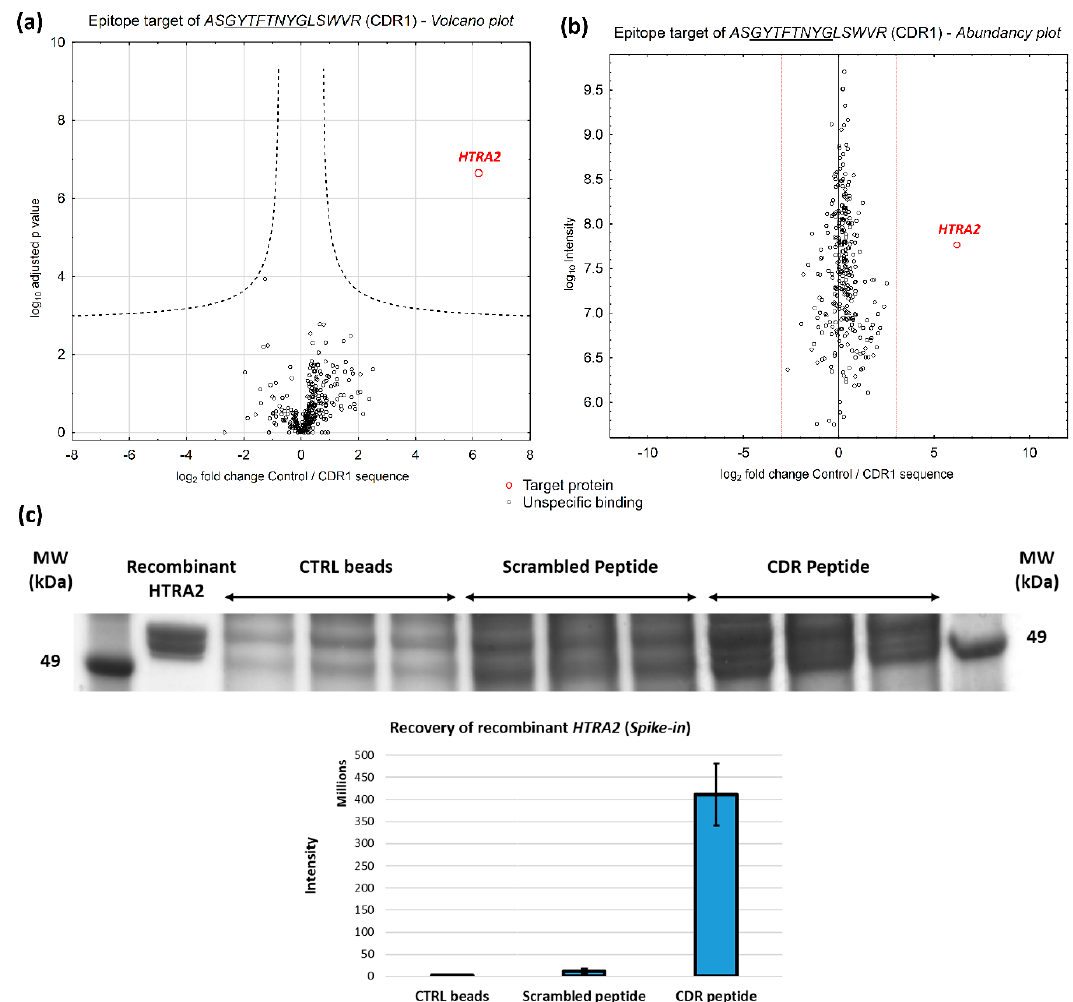
Figure 2. Identification of potential epitope targets of the CDR peptides by affinity-based proteomic strategy with 5 mg homogenized pig retina. ( a ) Volcano plot showing log2 fold change plotted against –log10 adjusted p values for samples from CDR-labeled bead group ( n = 3), versus samples from control bead group (n = 3) ( p < 0.001; log2 fold change >3). Mitochondrial serine protease HTRA2 was identified as high-affinity interaction partner for the synthetic CDR1 peptide ASGYTFTNYGLSWVR . ( b ) Abundancy plot showing log2 fold change plotted against –log10 adjusted cumulative intensity. HTRA2 represents a rare protein in the porcine retina and confirms the specific interaction with the synthetic CDR1 peptide. ( c ) Spike-in experiment of 2 µg recombinant HTRA2 in 5 mg homogenized pig retina followed by affinity-based proteomics. The image of the 1-D SDS PAGE shows the eluate fractions of the di ff erent bead groups (Control (CTRL) beads and beads labeled either with scrambled peptide or CDR peptide, n = 3). In-gel trypsin digestion and LC-MS / MS revealed that CTRL beads